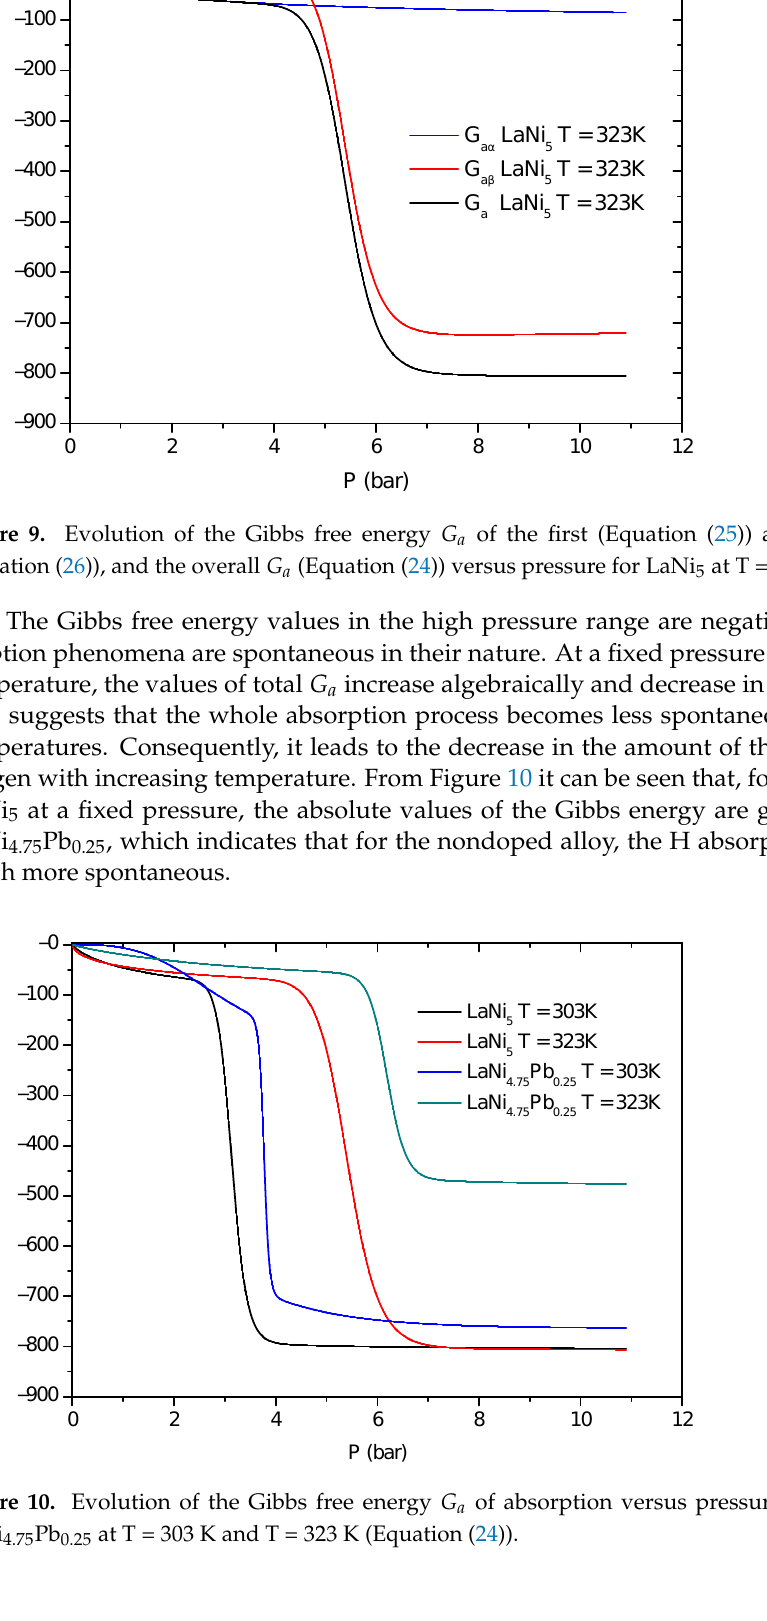
Figure 10. Evolution of the Gibbs free energy G a of absorption versus pressure for LaNi 5 and LaNi 4.75 Pb 0.25 at T = 303 K and T = 323 K (Equation